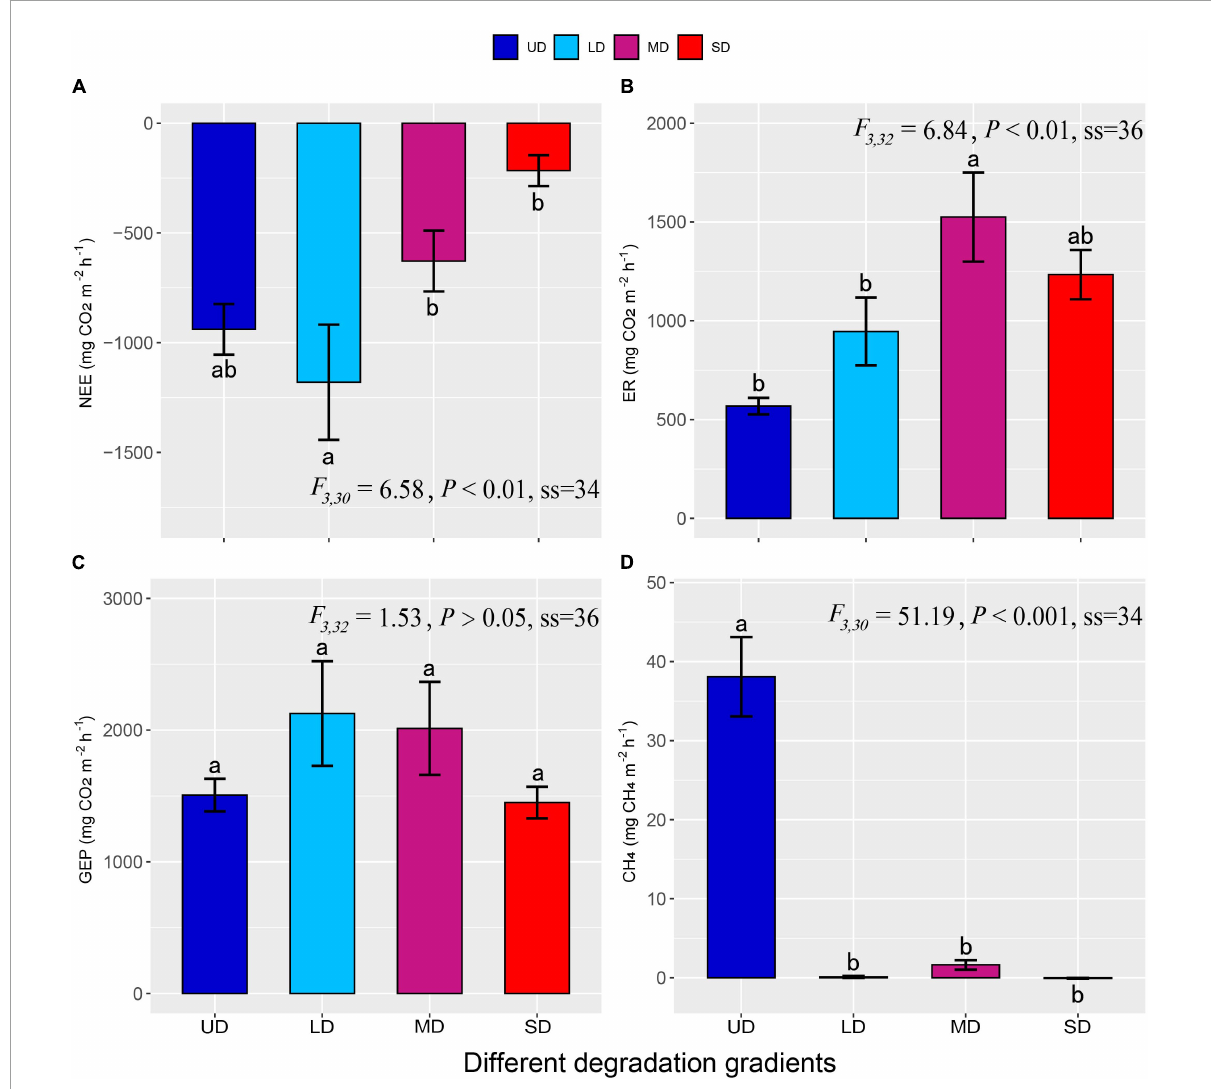
FIGURE3 The NEE (A) , ER (B) , GEP (C) , and CH 4 (D) fluxes in the alpine wetlands degraded to different degrees. Different lowercase letters indicate a significant difference at the P < 0.05 level (error bars indicate the standard errors). UD, undegraded wetland; LD, lightly degraded wetland;